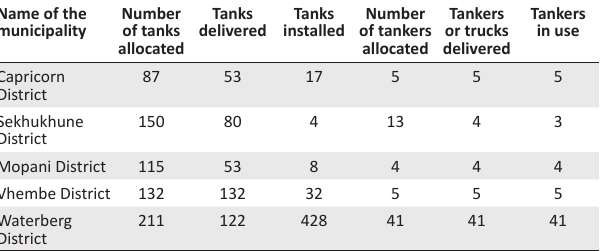
TABLE 2: Limpopo intervention as of 15 June 2020 (DWS 15 June).